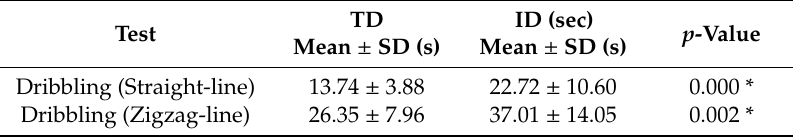
Figure 13. Results of T dribbling _ straight and T dribbling _ zigzag . The participants with ID displayed longer dribbling times than the TD participants in both tests. Table 9. ANOVA results of the dribbling time for the two